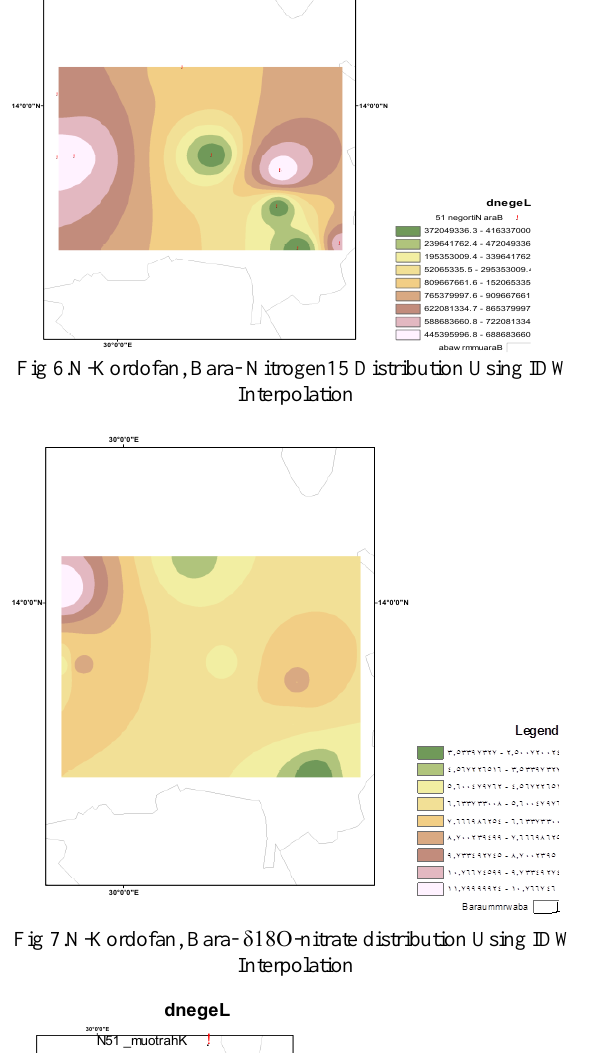
Fig10. Khartoum Land cover and shallow boreholes special